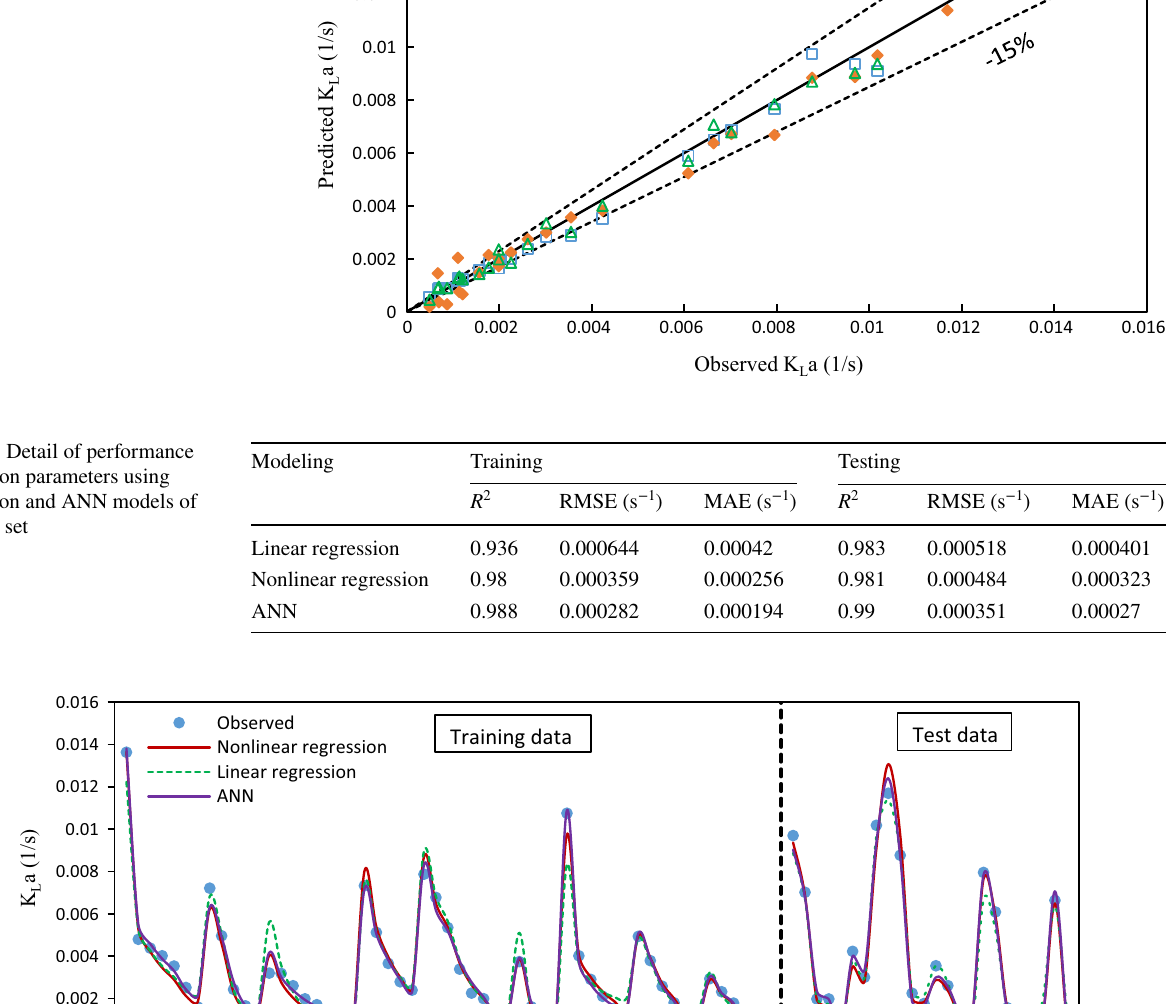
Fig. 10 Experimental versus predicted values of K L a by nonlinear regression, linear regression and ANN with test- ing data